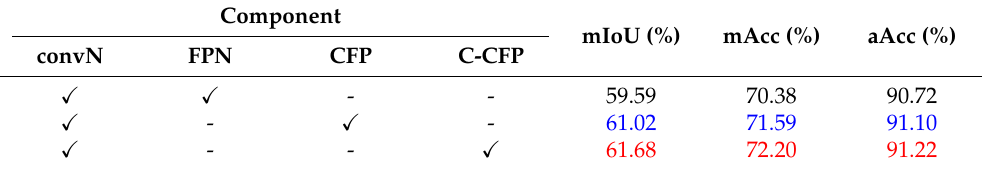
Table 4. Comparing the FPN structure with our proposed CFP and connected CFP (C-CFP) structures.